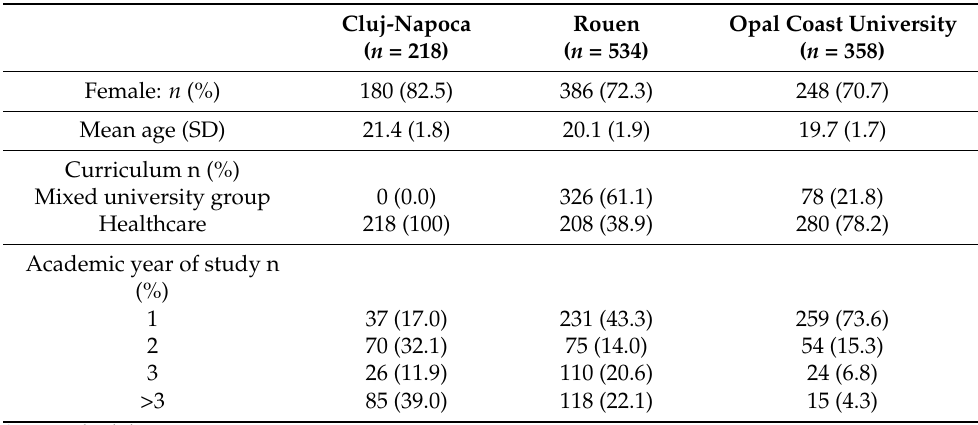
Table 1. Characteristics of university students from the three universities ( N = 1110).